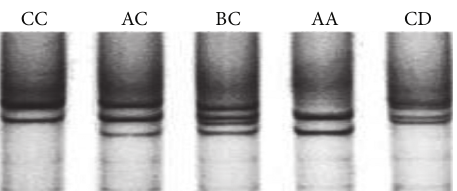
Figure 7: Amplified PCR product of the UCP3 gene on 10% PAGE.